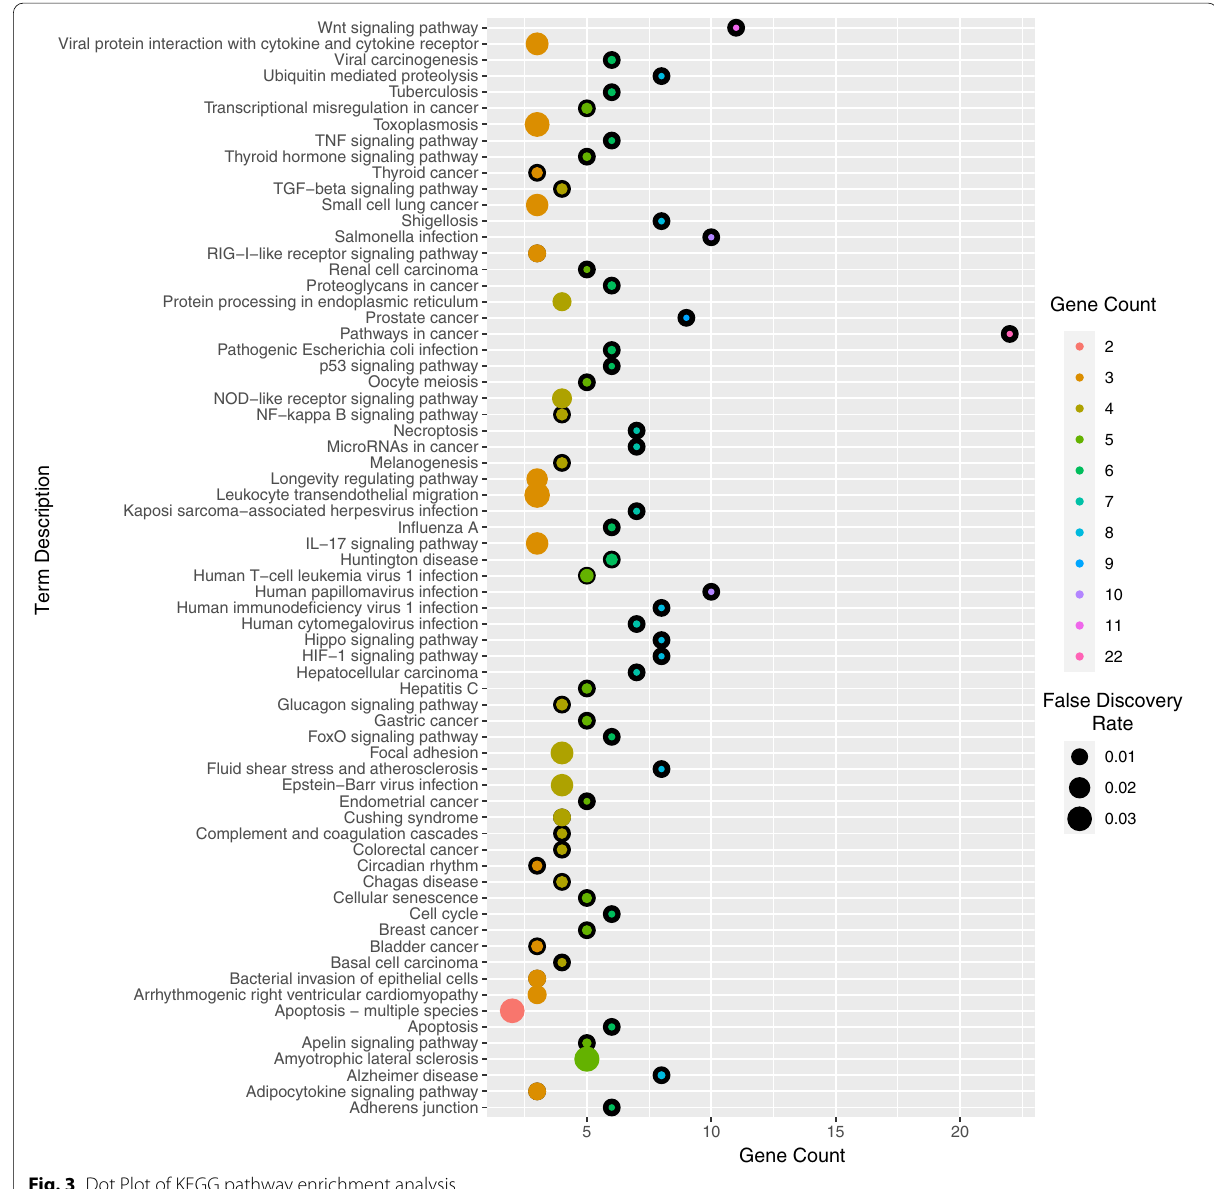
Fig. 3 Dot Plot of KEGG pathway enrichment